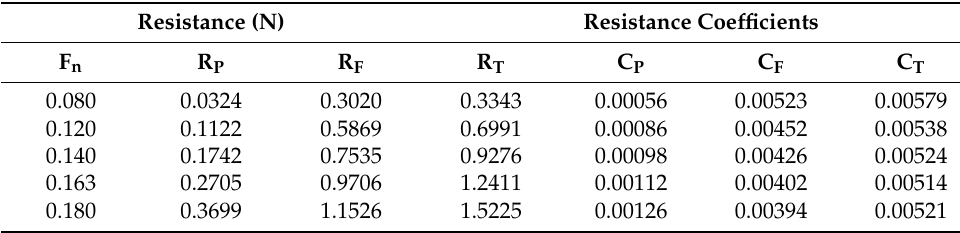
Table 4. Resistance acting on the original model in calm water.